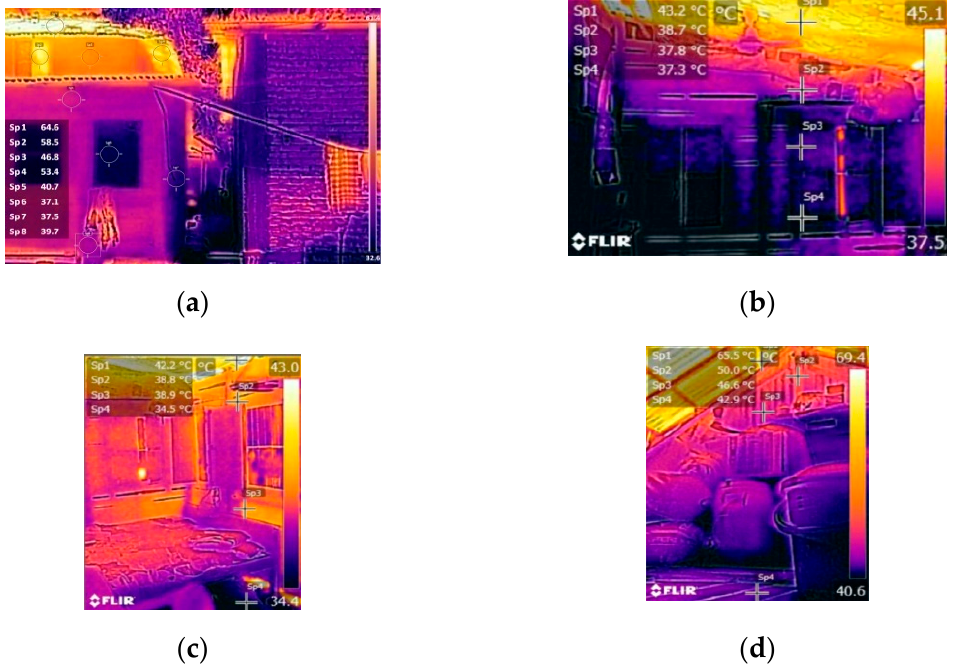
Figure 5. Surface temperature of H-1: ( a ) outdoors, ( b ) indoor west wall, ( c ) south wall and ( d ) attic.